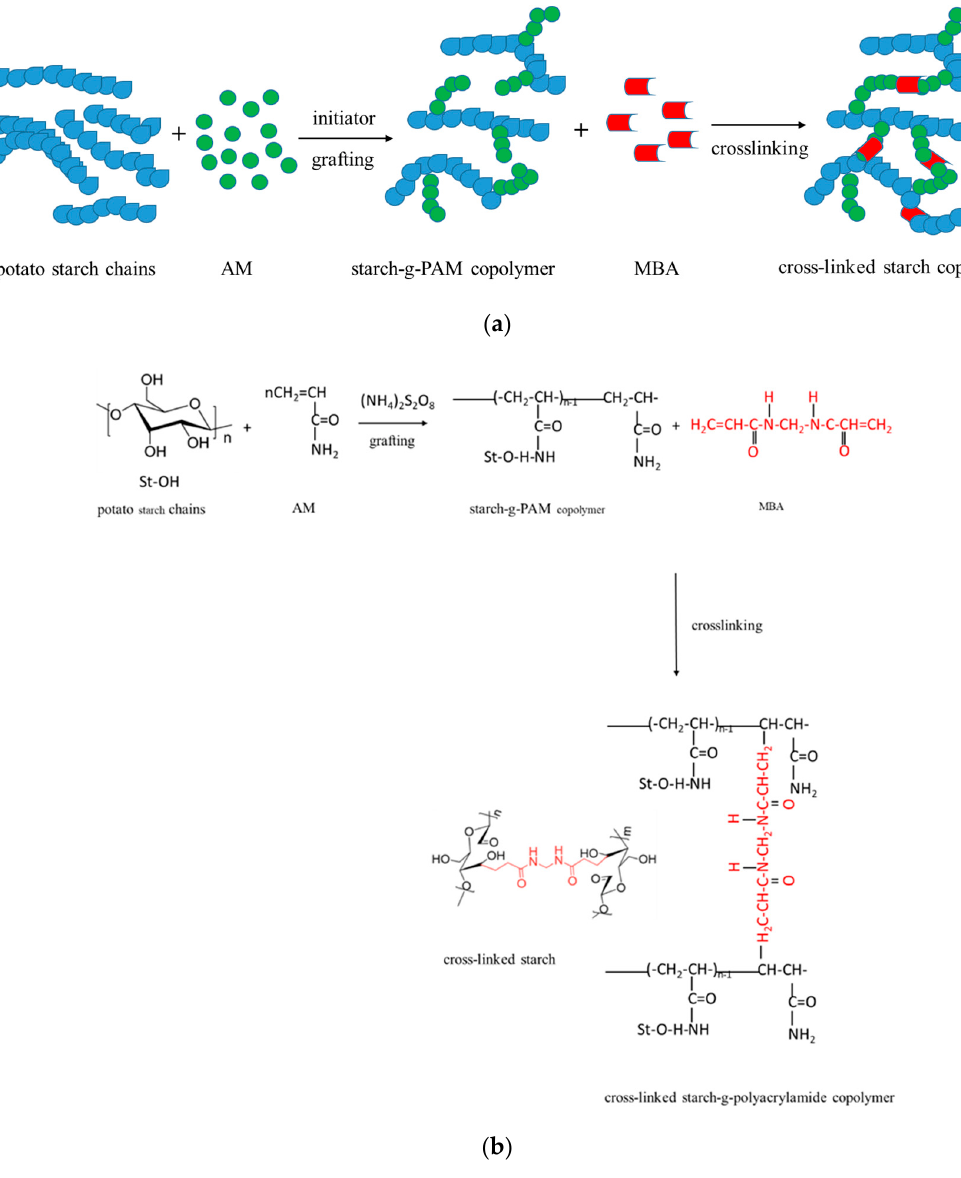
Scheme 2. Schematic illustration: ( a ) of representation for formation of three-dimensional network of cross-linked starch-g-PAM absorbents; ( b ) of grafting starch by polyacrylamide and cross-linking starch SAP formation.